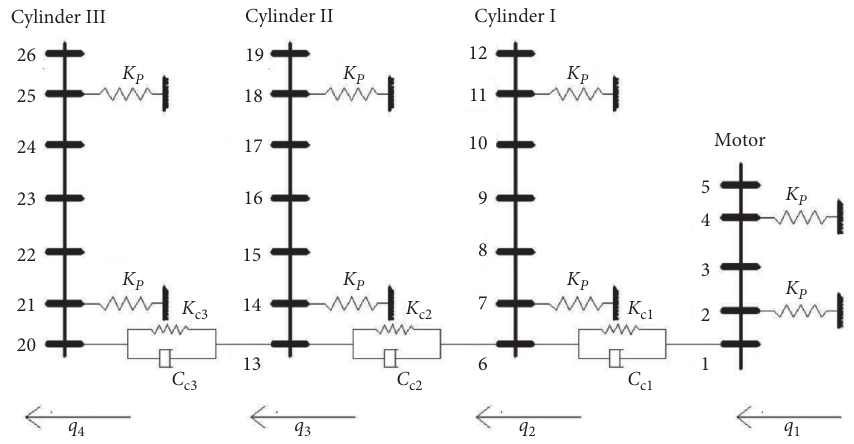
Figure 2: Dynamic calculation model of the